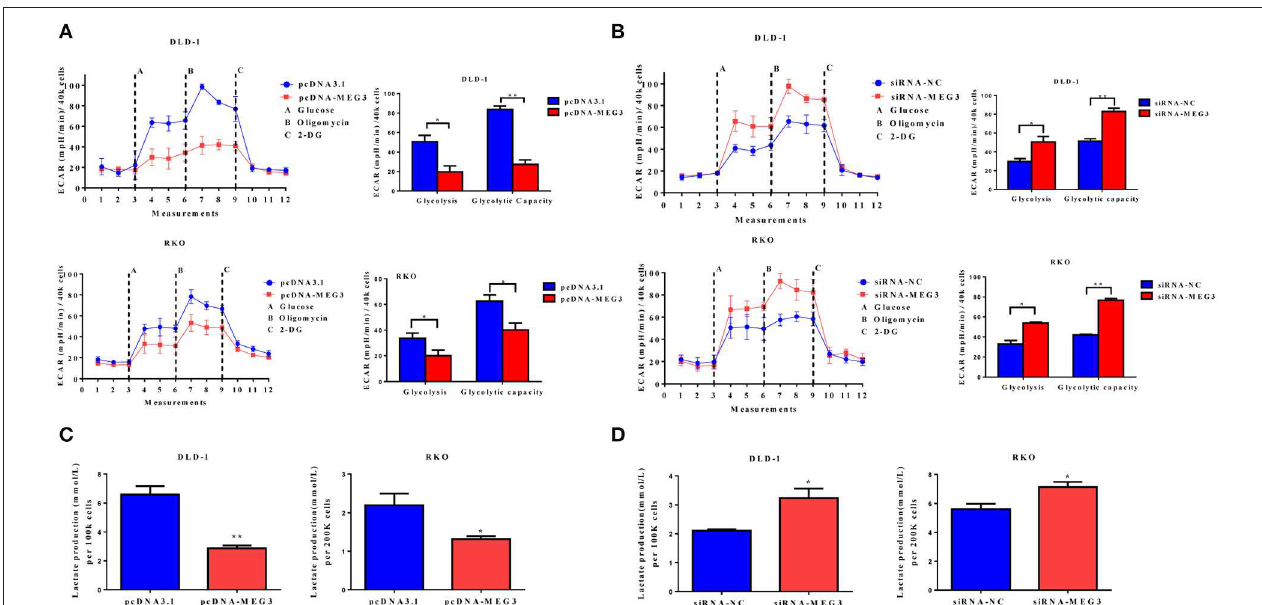
FIGURE 3 | Maternally expressed gene 3 ( MEG3 ) influences glucose metabolism in colorectal cancer (CRC) cells. The extracellular acidification rate (ECAR) was measured by glycolysis stress tests in CRC cell lines with MEG3 overexpression (A) and in those with MEG3 knockdown (B) . Lactate production was measured in the culture medium of CRC cell lines with strong expression of MEG3 (C) and weak expression of MEG3 (D) . Data are expressed as mean ± standard deviation from three independent experiments. * P < 0.05, ** P <